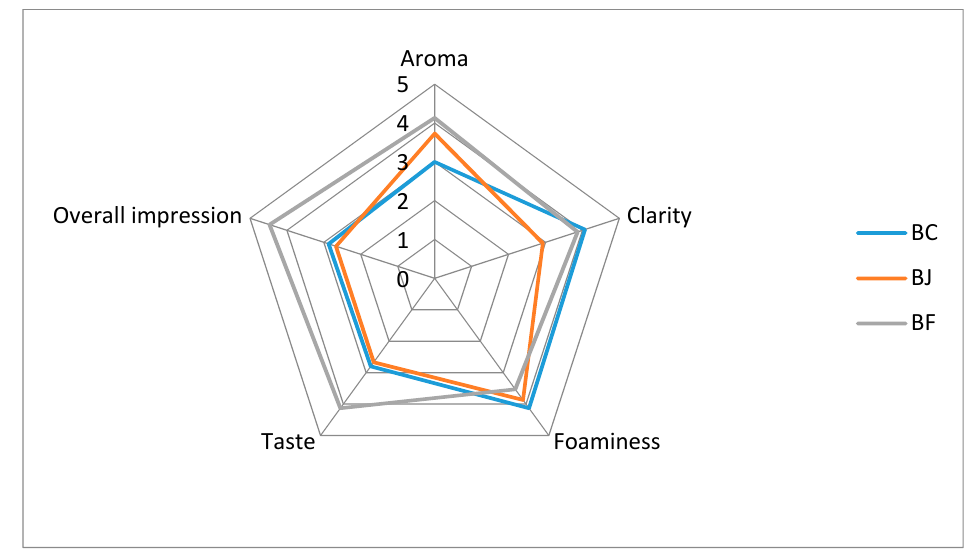
Figure 1. Organoleptic analysis of tested beers.